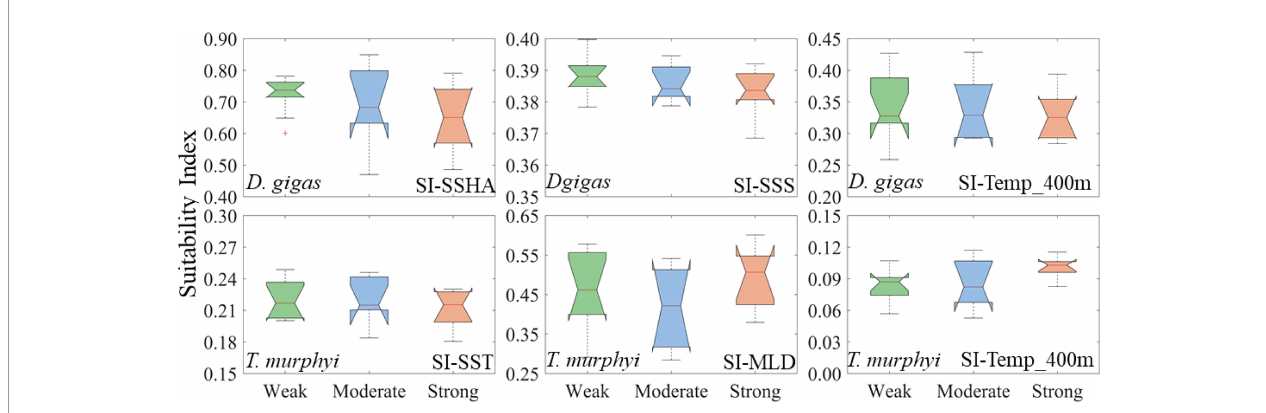
FIGURE 3 | Changes of suitability index of key environmental factors of Dosidicus gigas and Trachurus murphyi under El Niño events with different intensities. (The nodes of the boxplot from top to bottom are the upper edge, upper quartile, median, lower quartile, and lower edge, with “ + ” representing